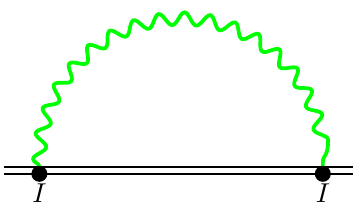
Figure 1 . Self-energy diagram for a generic radiative multipole source I . The green wavy field represents the gauge/gravity interaction, while the black double line stands for the composite